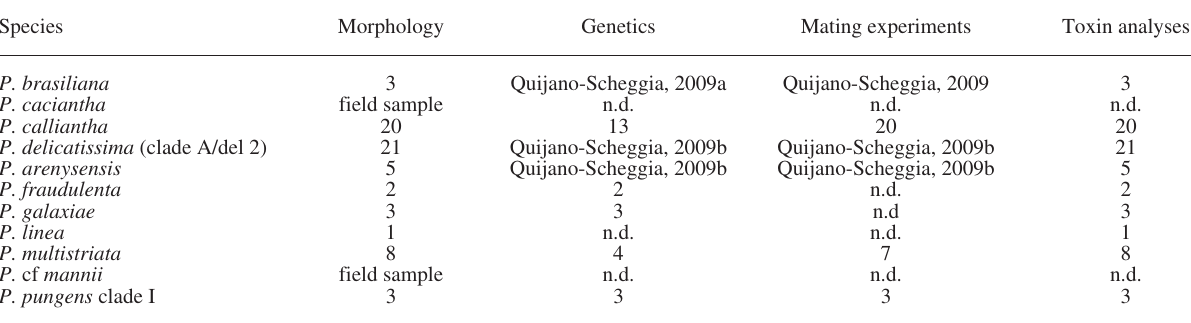
Table 1. – Summary of the Pseudo-nitzschia species and the characterization carried out. The numbers indicate the number of clonal cultures established for each species for morphology and genetics characterization, mating experiments and toxin analyses. References to other studies with additional information are indicated; n.d. = data not available.